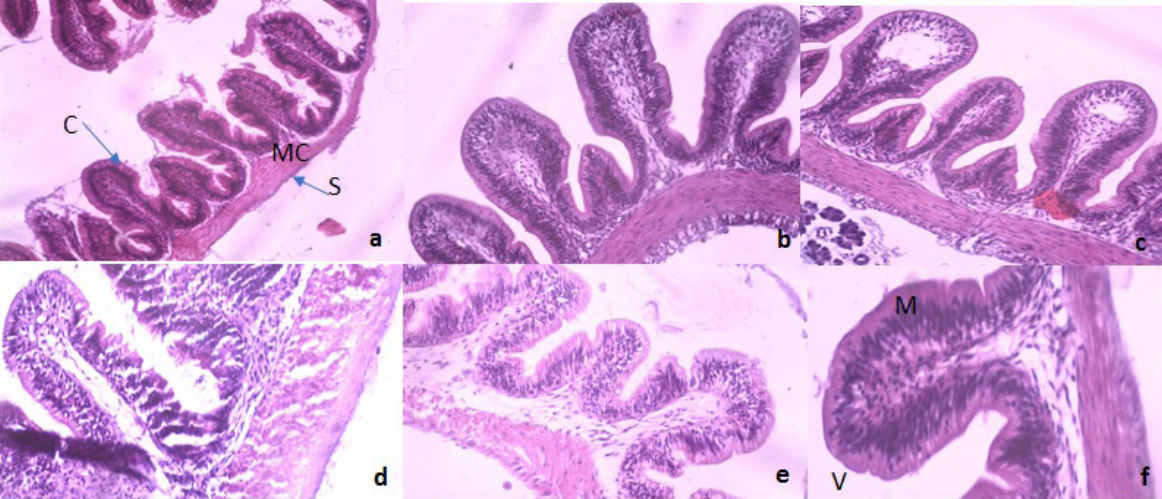
Figure 4 - Photomicrograph of the middle section intestinal of the Nile tilapia fingerlings supplemented with increasing levels of alcoholic extract of propolis. Treatment with 0 g/kg = a , where goblet cell (C), muscular tunic (MC) and serous tunic (S) are observed; 1 g/kg = b ; 2 g/kg = c ; 3 g/kg = d ; 4 g/kg = e . In f, is observed mucosa epithelium (M) and villi (V). He staining, 10X